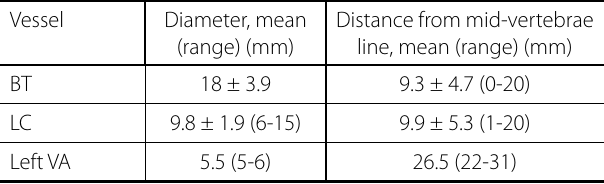
Table 6. Aortic arch branch measurements